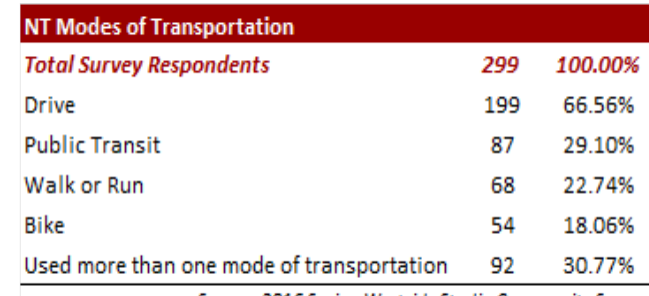
Figure 5. Mode split to access North Temple. source: created by authors for this paper.